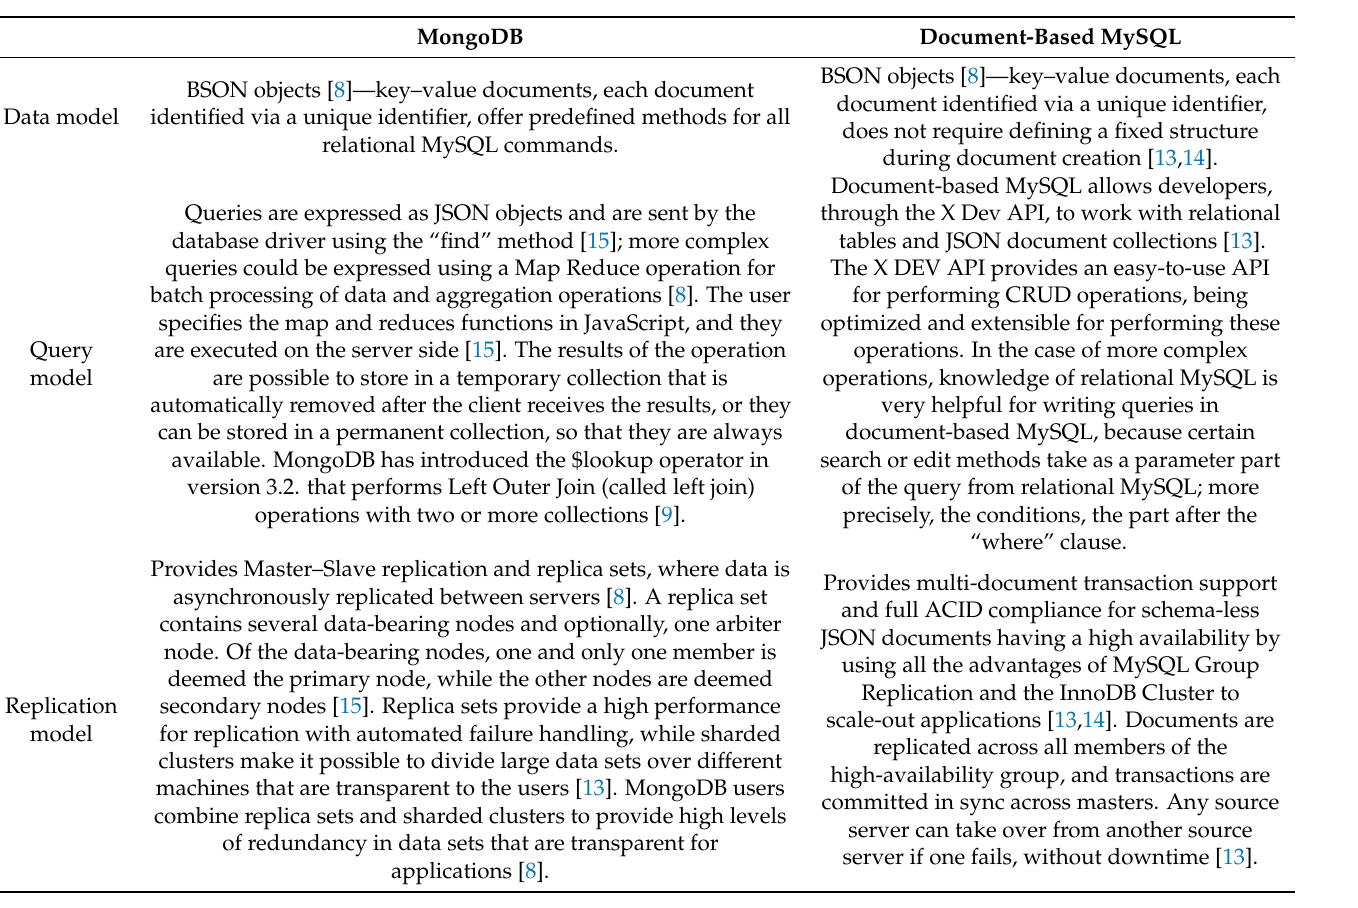
Table 1. Comparison of the characteristics between MongoDB and document-based